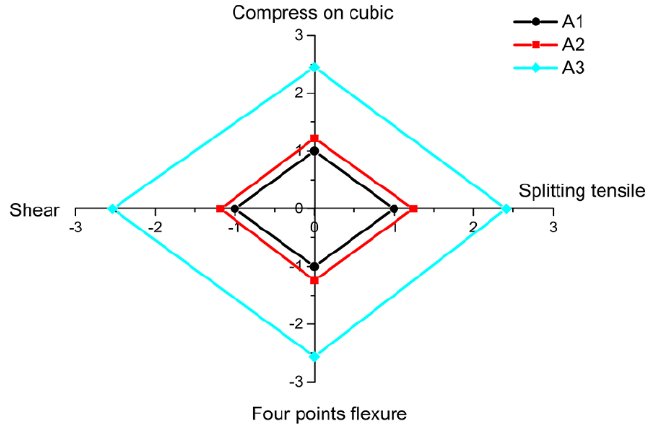
Figure 10. Strength of group A compared to that of